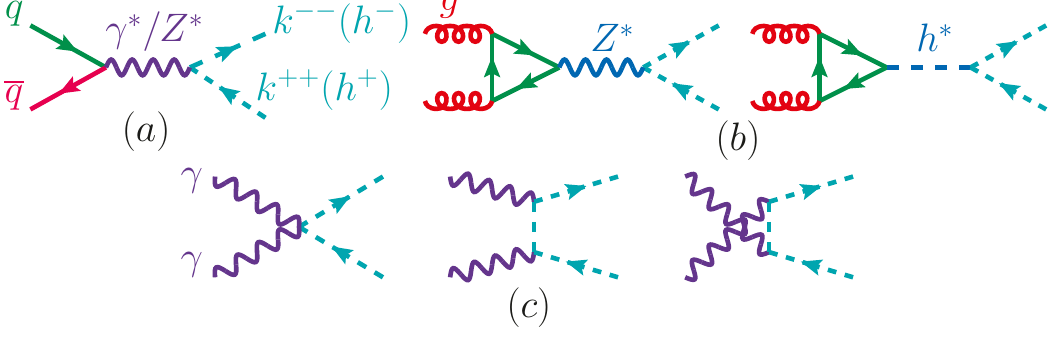
Figure 2 . Born-level partonic graphs depicting the production of k −− k ++ pairs (or h − h + pairs) in the Zee-Babu model from the (a) Drell-Yan process, (b) gluon fusion, (c) photon fusion. To simulate this at NLO with the SM_ZeeBabu libraries and mg5amc , we use the commands: